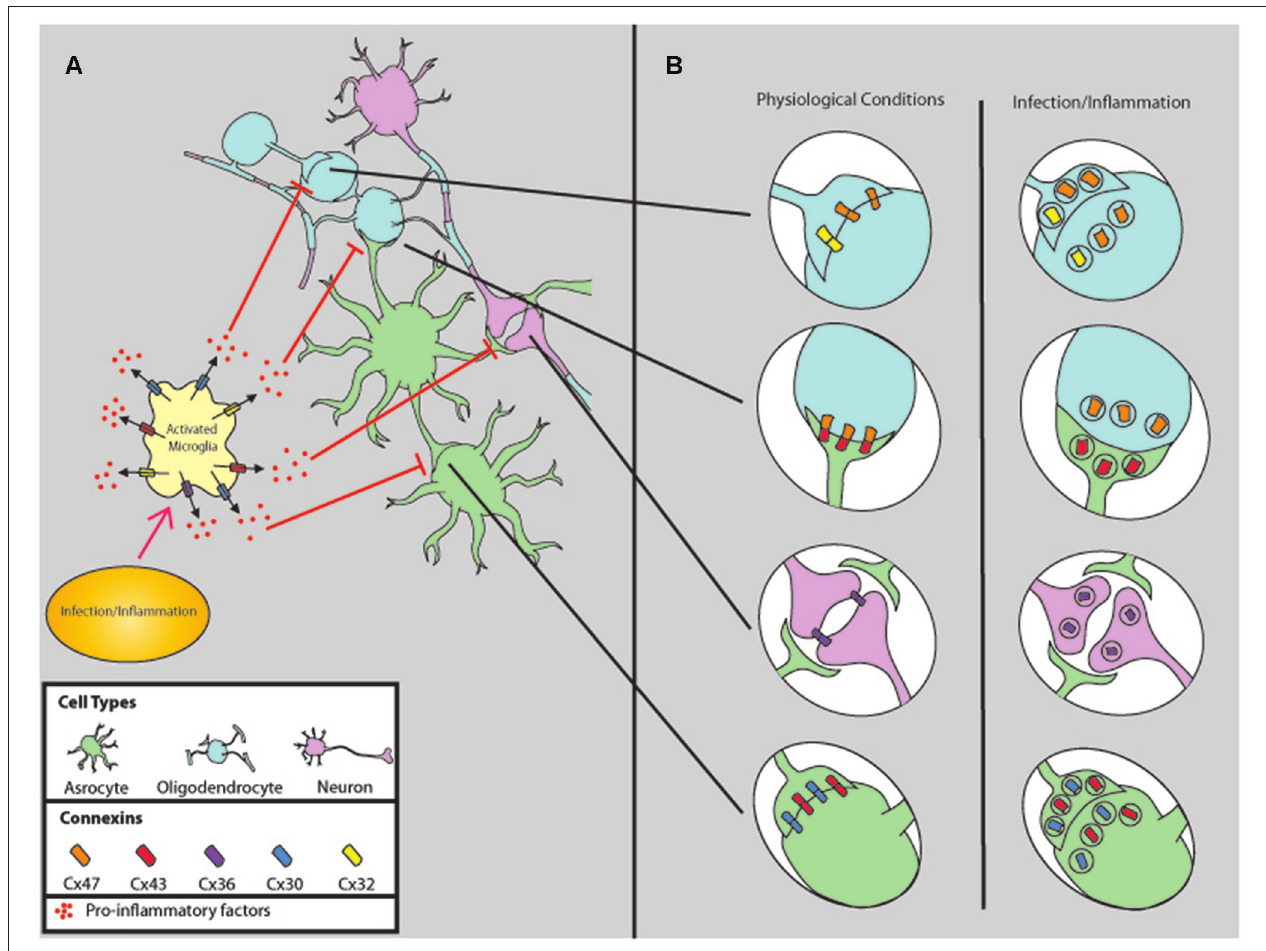
microglia activation and release of pro-inflammatory factors such as PGEs, ATP, neurotransmitters, cytokines, and chemokines. (B) Corresponds to the changes in GJ synaptic connections in response to inflammation and infectious agents. Most of these factors induce internalization, degradation, and reduction of